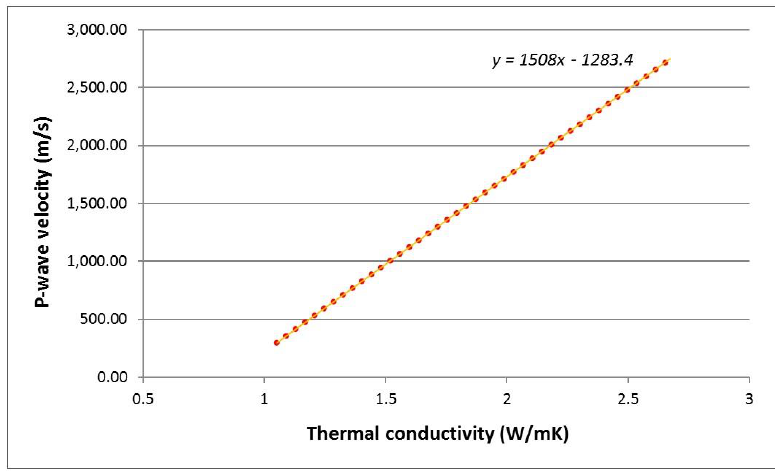
Figure 4. Thermal conductivity versus P-wave velocity in the study area.